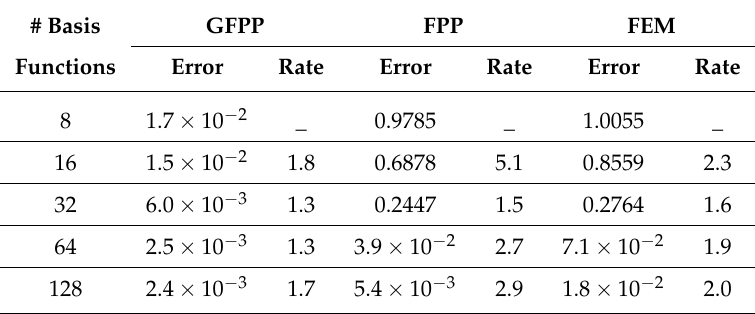
Table 3. The error estimation and convergence rate of numerical solutions to the analytic solution in Example